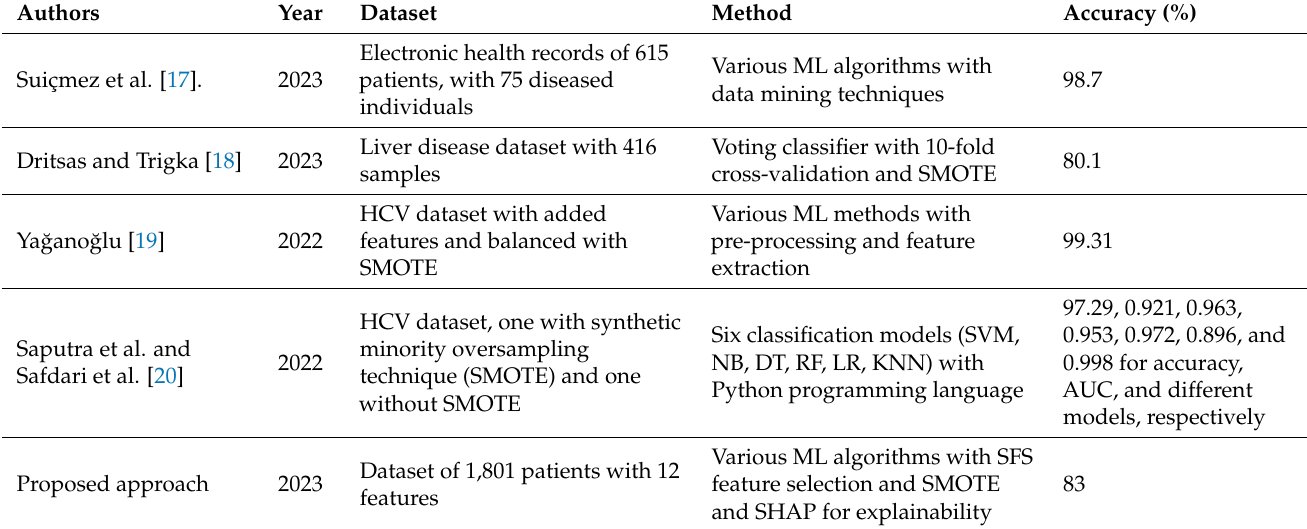
Table 5. Comparison of different machine learning models in predicting hepatitis C